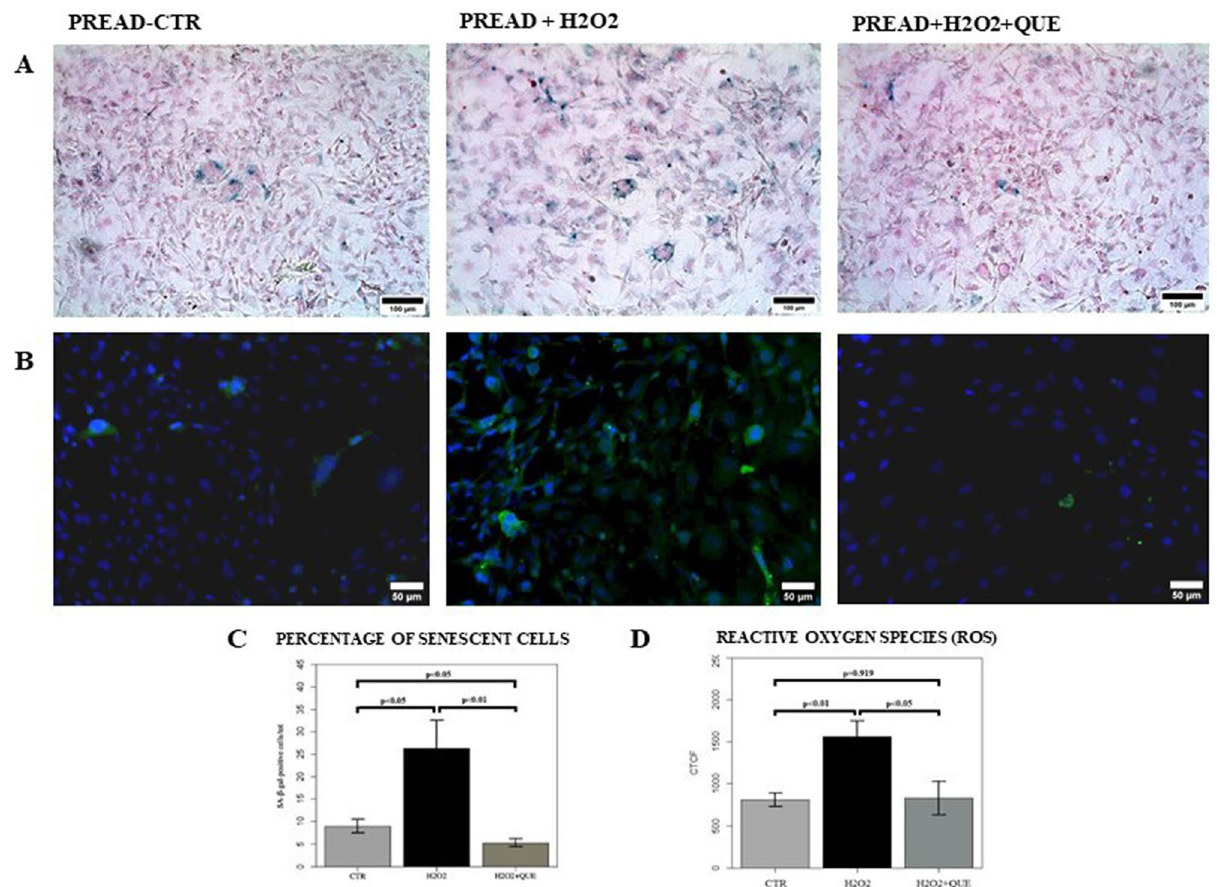
Figure 5. ( A ) Evaluation of the pre-adipocytes senescence with the specific staining for β-galactosidase. Representative images of cell senescence in pre-adipocytes (PREAD-CTR), pre-adipocytes stimulated with H 2 O 2 (PREAD + H2O2) and treated with H 2 O 2 plus quercetin (PREAD + H2O2 + QUE). Scale = 100 μm. ( B ) Significant images of the accumulation of intracellular ROS (in green) in pre-adipocytes (PREAD-CTR), pre-adipocytes treated with H 2 O 2 (PREAD + H2O) and pre-adipocytes treated with H 2 O 2 plus quercetin (PREAD + H2O2 + QUE). Scale = 50 μm. ( C ) Histograms showing the percentage of senescent cells